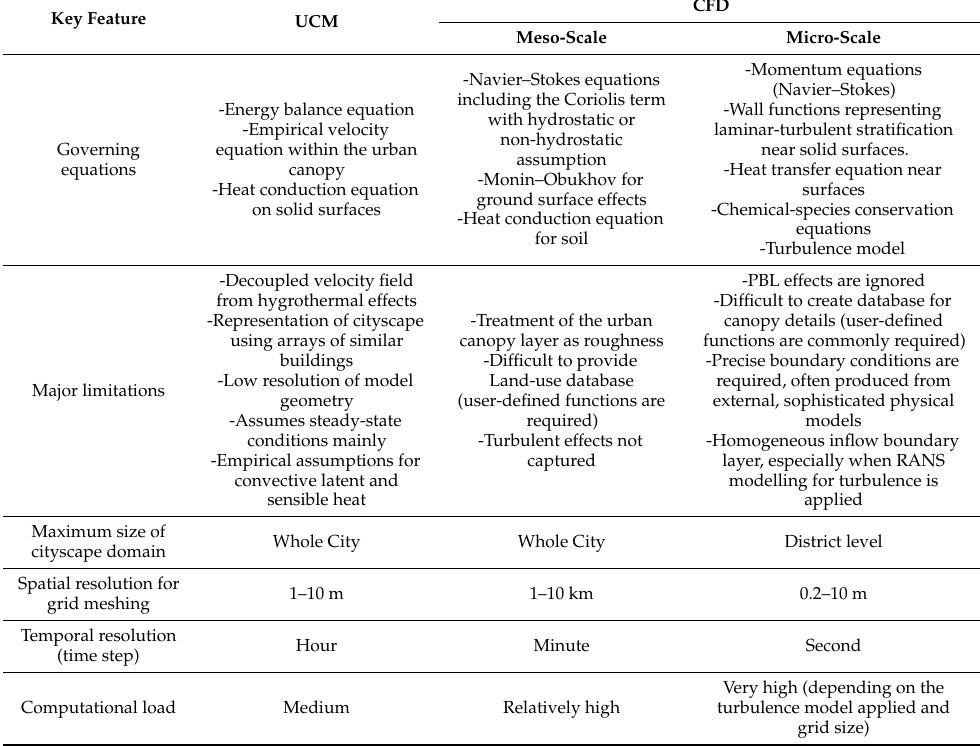
Table 3. Collation of major UHI simulation